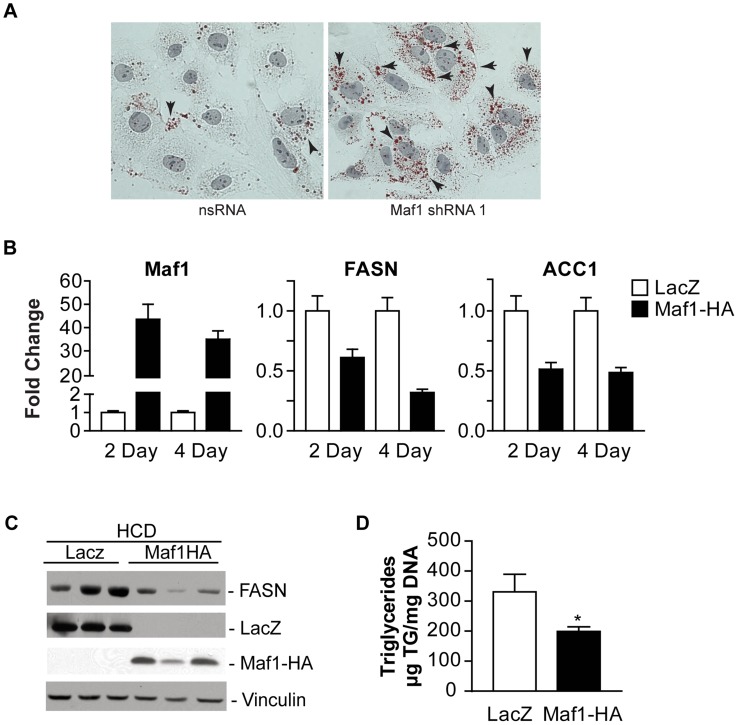
Maf1 controls intracellular lipid accumulation and de novo lipogenesis.(A) Maf1 represses intracellular lipid accumulation. Huh-7 cells infected with nsRNA (left) or Maf1 shRNA (right) were stained with Oil Red O and Mayer's Hematoxylin. Intracellular lipid droplets were detected as red spheres and nuclei are shown in purple. Magnification 40x. (B) Maf1 overexpression inhibits diet-induced lipogenic gene expression. Male C57BL mice injected with adenovirus overexpressing either Maf1-HA or LacZ were fed a high carbohydrate diet for 2 or 4 days. RNA was isolated from livers and qRT-PCR was performed with primers specific for FASN and ACC1. Fold changes are statistically significant: Student t-test, FASN; 2 day p = 0.0067, 4 day p = 0.0028; ACC1; 2 day p = 0.006, 4 day p = 0.021. (C) Protein lysates were isolated from the mouse livers fed a high carbohydrate diet for 4 days and were subjected to immunoblot analysis using antibodies against FASN, LacZ, HA (ectopic Maf1-HA), or vinculin. Representative samples shown. (D) Maf1 overexpression reduces triglyceride accumulation. Triglycerides were isolated from the livers of mice that were fed a high carbohydrate diet for 4 days and quantified. Values represent means ±S.E. (n = 4). Fold changes are statistically significant with p<0.018.